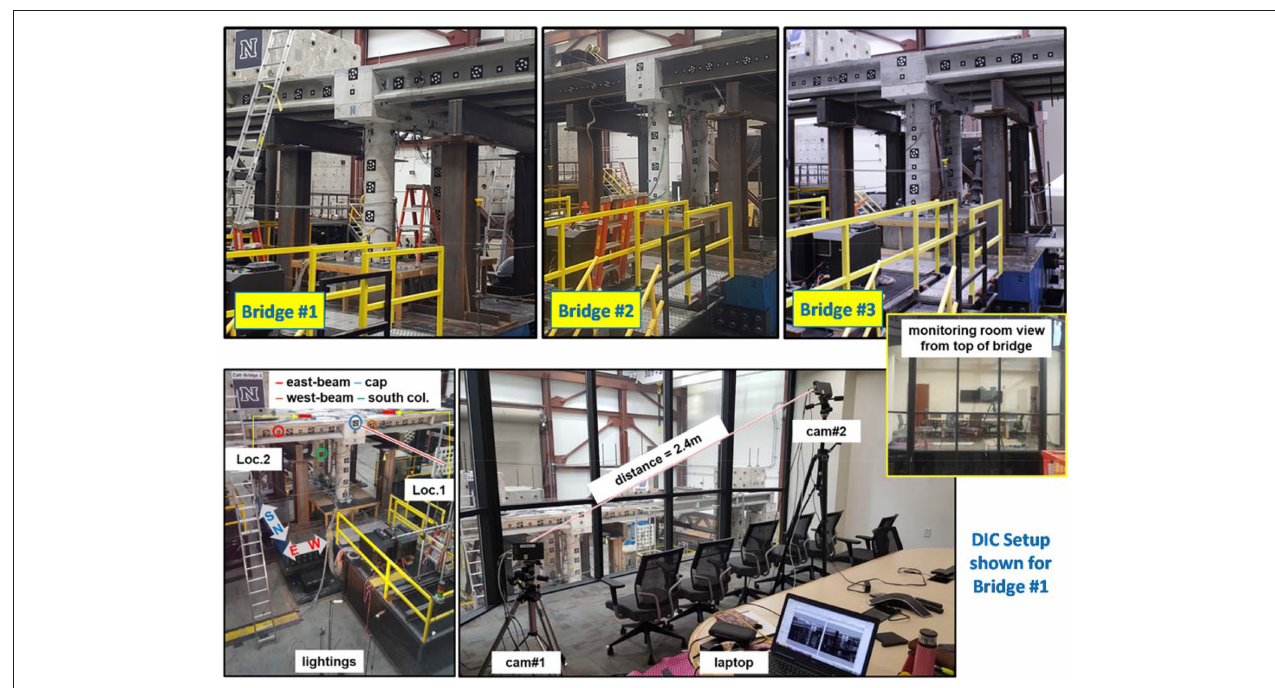
FIGURE 2 | Test setup and DIC targets for all three bridges along with the DIC cameras setup and selected targets for verification from Bridge #1